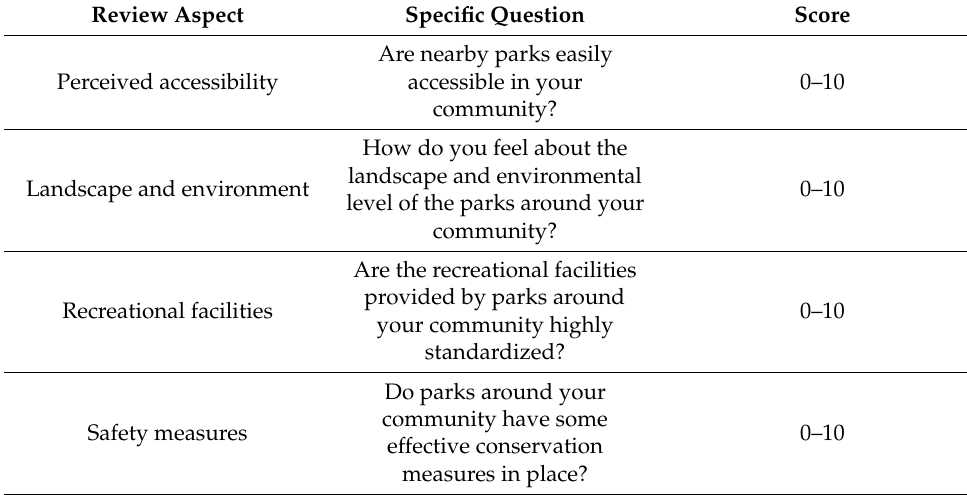
Table 3. Core questions of the interview questionnaire.